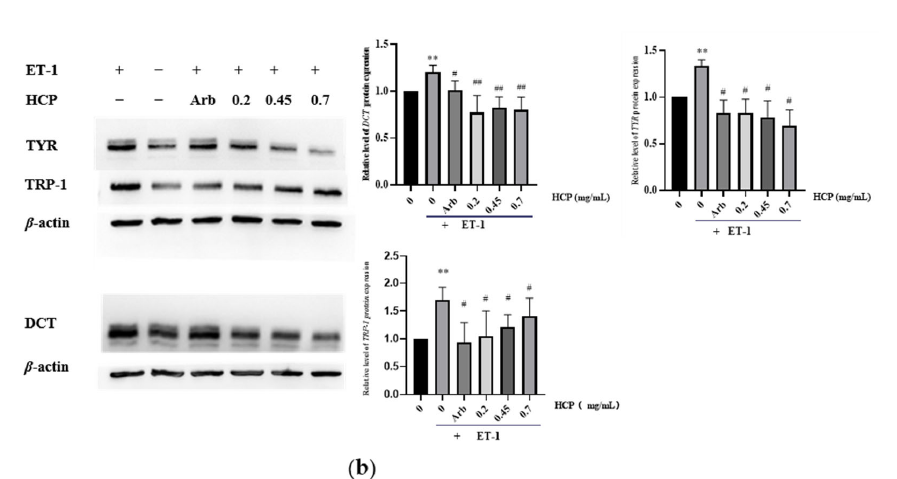
Figure 6. Effect of HCP on protein expression of TYR, TRP ‐ 1 and DCT. β ‐ actin served as internal control. ( a ) Expression levels of melanogenesis ‐ related protein, compared with α ‐ MSH group. ( b ) Expression levels of melanogenesis ‐ related genes, compared with ET ‐ 1 group. All data are expressed as mean ± SEM ( n ≥ 3) (** p < 0.01, and * p < 0.05 vs. the untreated control group; ## p < 0.01, and # p < 0.05 vs. α ‐ MSH ‐ treated group or ET ‐ 1 ‐ treated group).